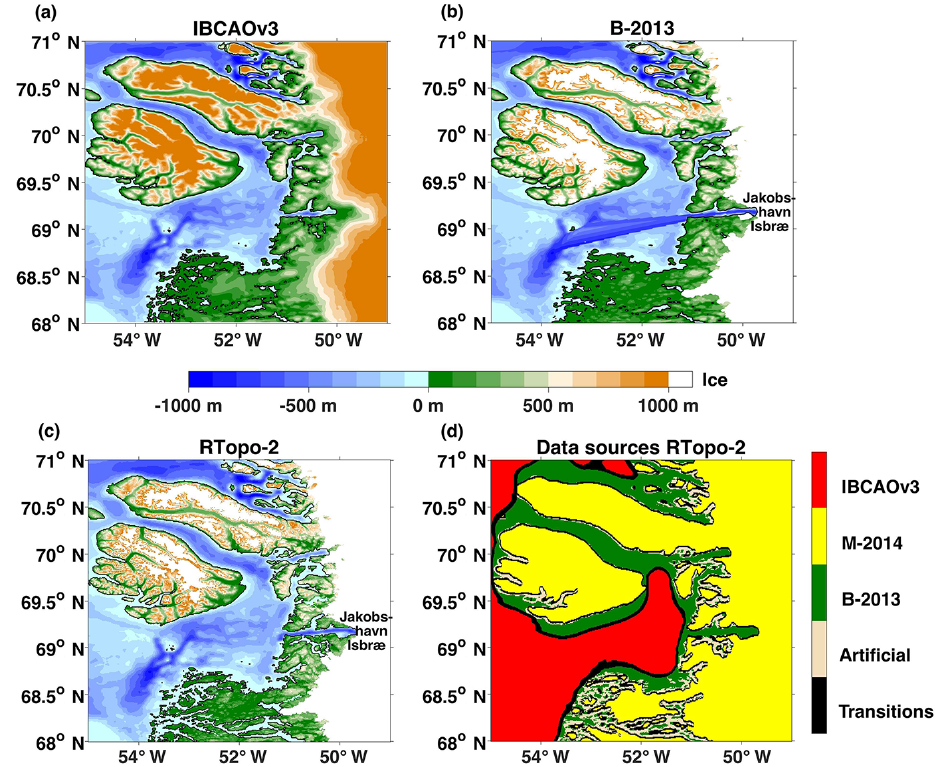
Figure 3. Coastal and shelf region in the west of Greenland, including Jakobshavn Isbræ. Maps show the ocean bathymetry/surface elevation in IBCAOv3 (a) , ocean bathymetry/bedrock elevation in B-2013 (b) , ocean bathymetry/bedrock elevation in RTopo-2 (c) , and the data sources for RTopo-2 (d) . The colour scale is identical for all bathymetry maps. White shading indicates grounded ice and floating ice tongues; black lines mark the coastline. The colour flags of the different data sources are identical to Fig.